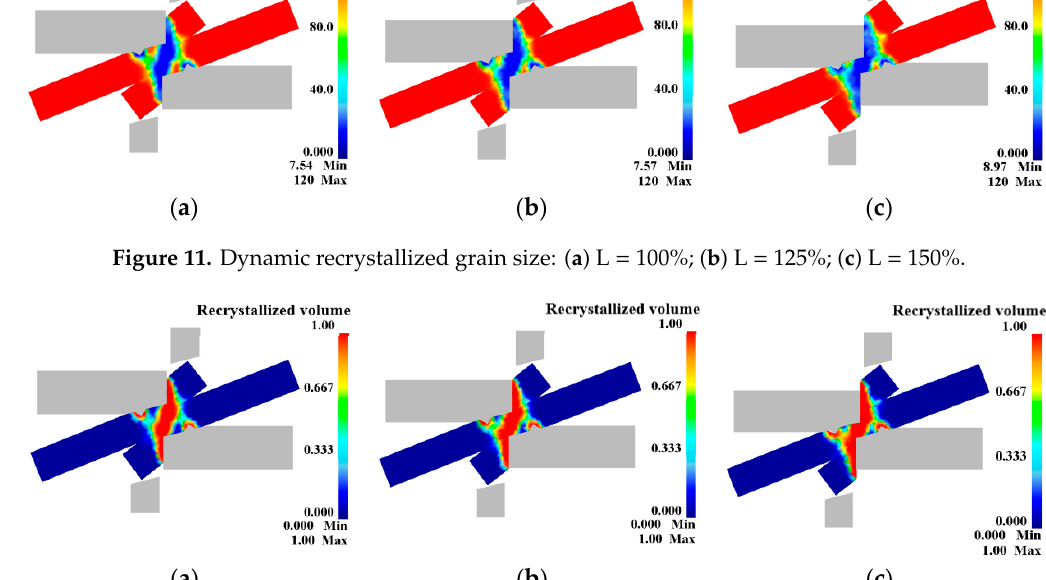
Figure 13. Tracking point location.